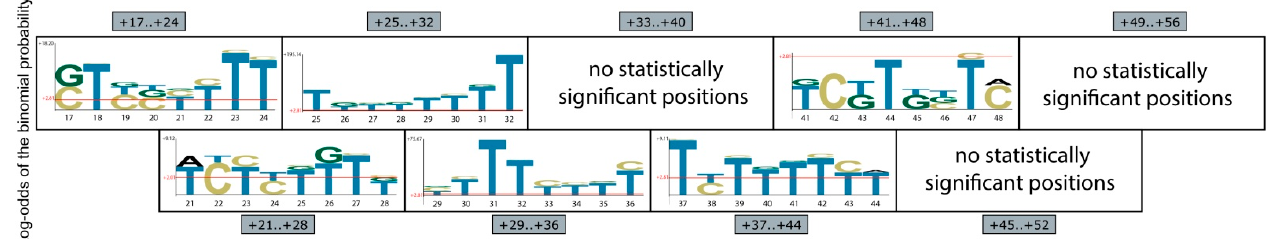
Figure 5. Position weight matrix logos for sequences that dramatically increase ( ≥ 10 ‐ fold) eGFP mRNA level according to the MPRA screening results. A significance p ‐ value threshold level of 0.05 is indicated by red horizontal lines [94].